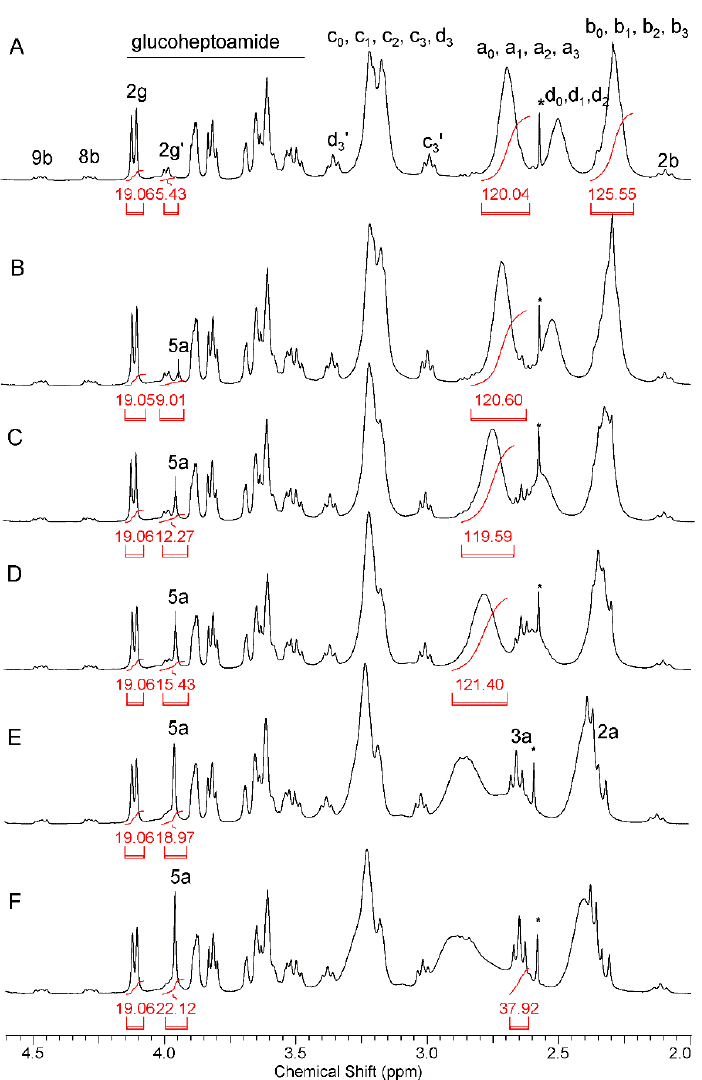
Figure 3. The 1 H NMR spectra of ( A ) G3 4B24gh in D 2 O; ( B )–( F ) G3 4B24gh (6.2 mM in D 2 O) containing 1.8 ( B ), 3.4 ( C ), 5.0 ( D ), 8.0 ( E ), and 10 ( F ) equivalents of ALA. Final concentration of ALA in case